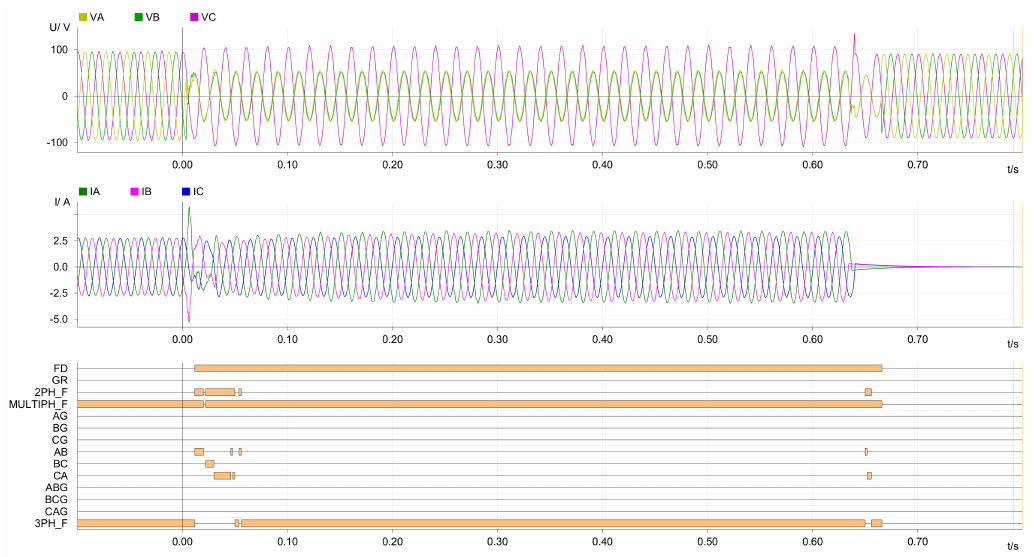
Figure 13. Faulted phase selector when AB fault is applied and K - factor = 3.5 using Strategy A.